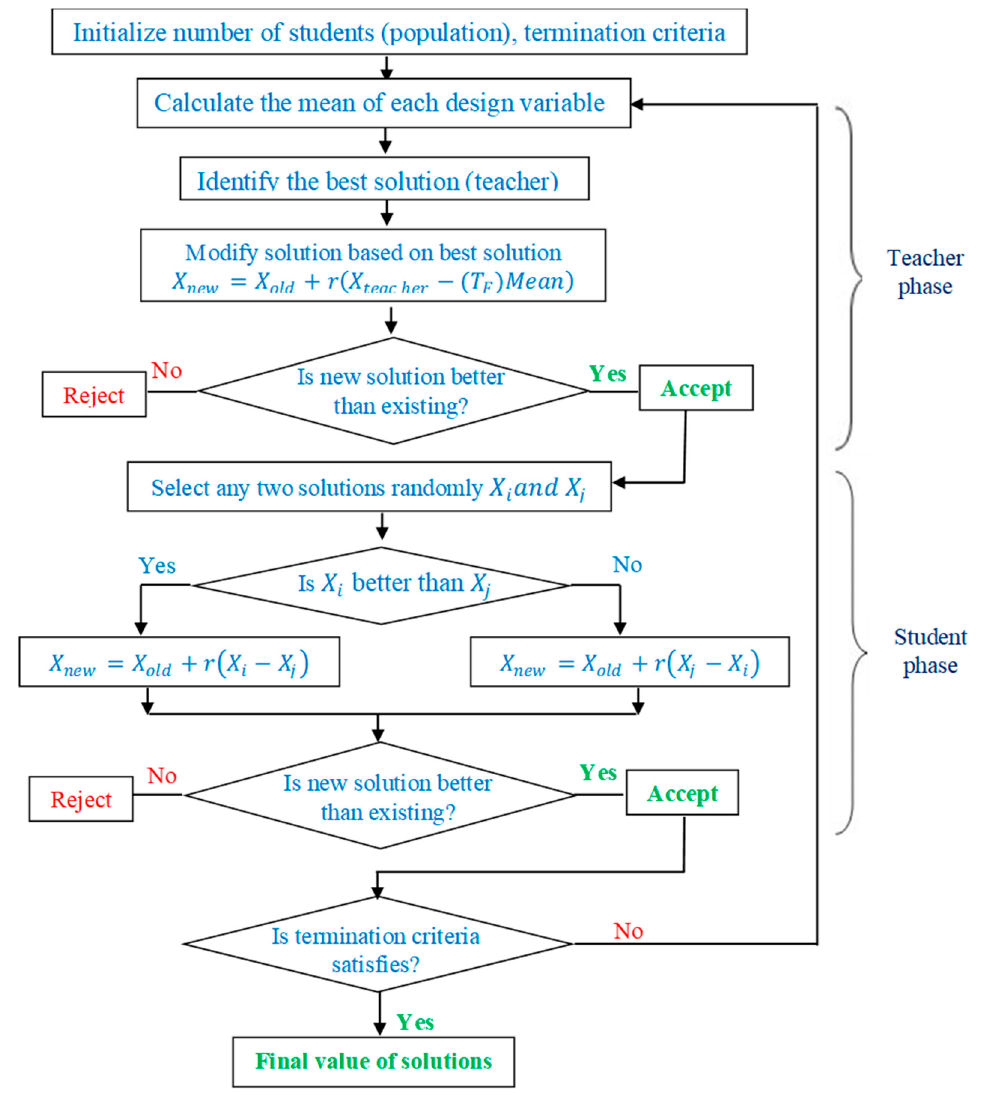
Figure 1. Flowchart of the TLBO algorithm.